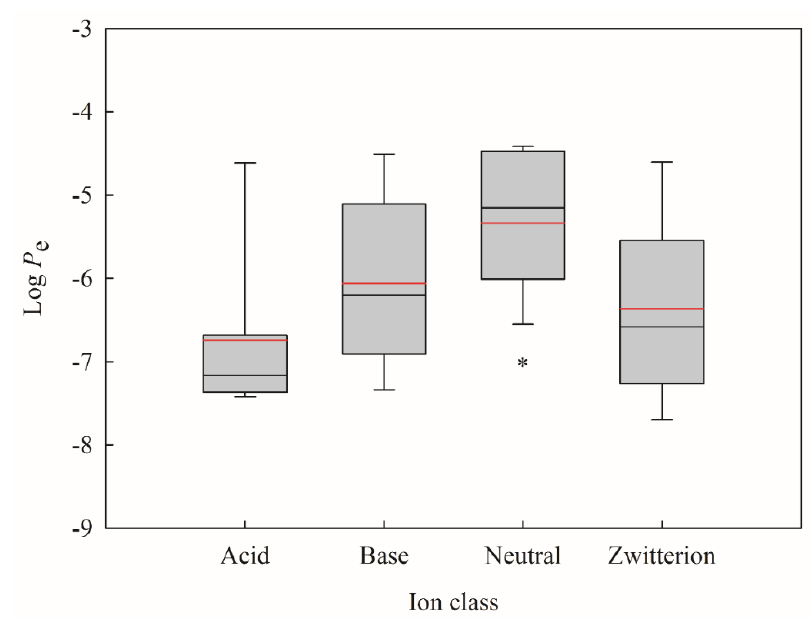
Figure 10. Box plot of log P e values for di ff erent ion classes, where the boxes represent the distribution of log P e from the 25th to the 75th percentile, the black and red lines depict the median and mean values, the whiskers denote the minimum and maximum values, and the asterisk indicates significant di ff erence between neutral and the others ( p < 0.05).